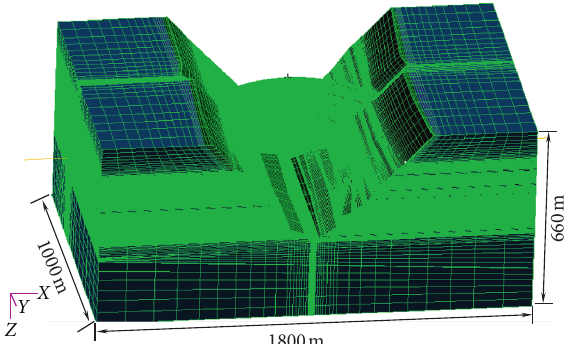
Figure 1: Computational grid diagram (Overall Diagram).